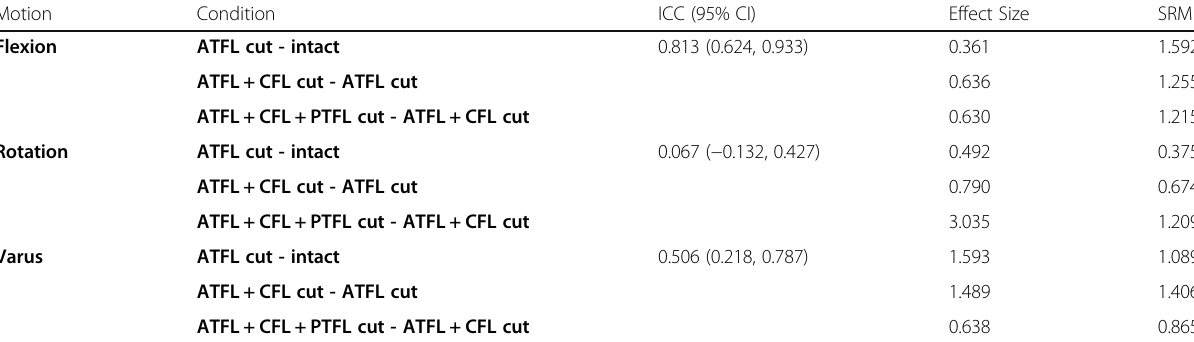
Table 2 Reliability and responsiveness of progressive ligament sectioning